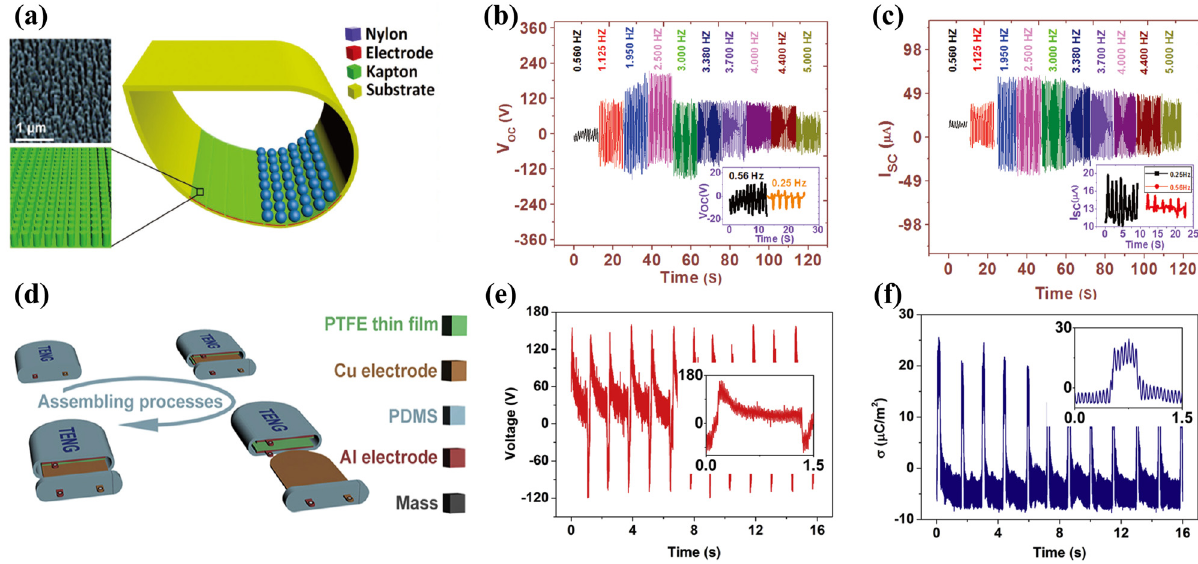
Figure 7: ( a ) Schematic diagram of duck TENG [ 66 ] , ( b and c ) the output response of voltage and current of duck TENG at di ff erent frequencies [ 69 ] , ( d ) bionic jelly fi sh TENG, and ( e and f ) output voltage and output current of bj - TENG at 0.75 Hz [ 71 ]